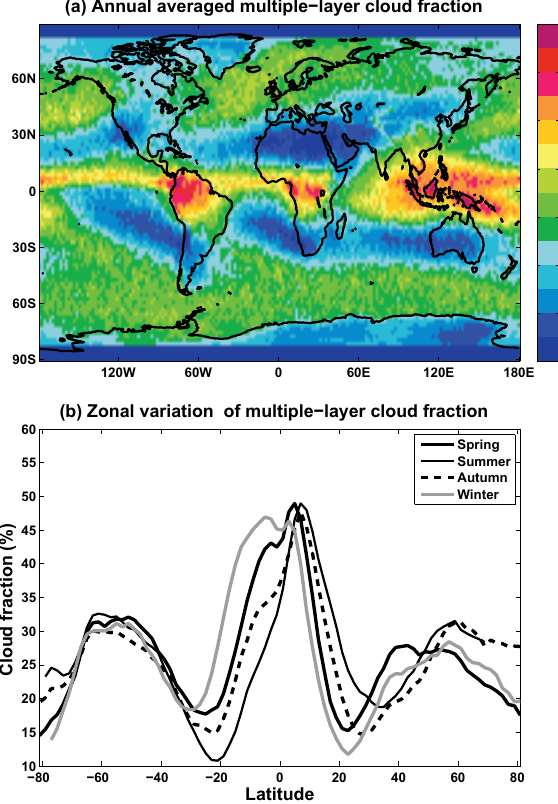
Figure 2. Zonal distributions of annual most frequently occur- ring multilayered cloud types based on the 2B-CLDCLASS-LIDAR